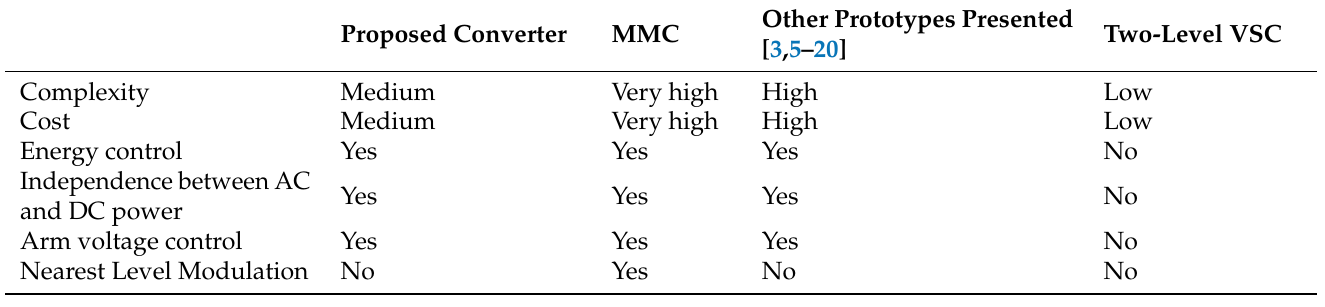
Table 1. Comparison between different converters.